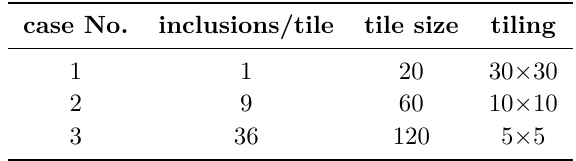
Table 1. Monodisperse tiling – settings.